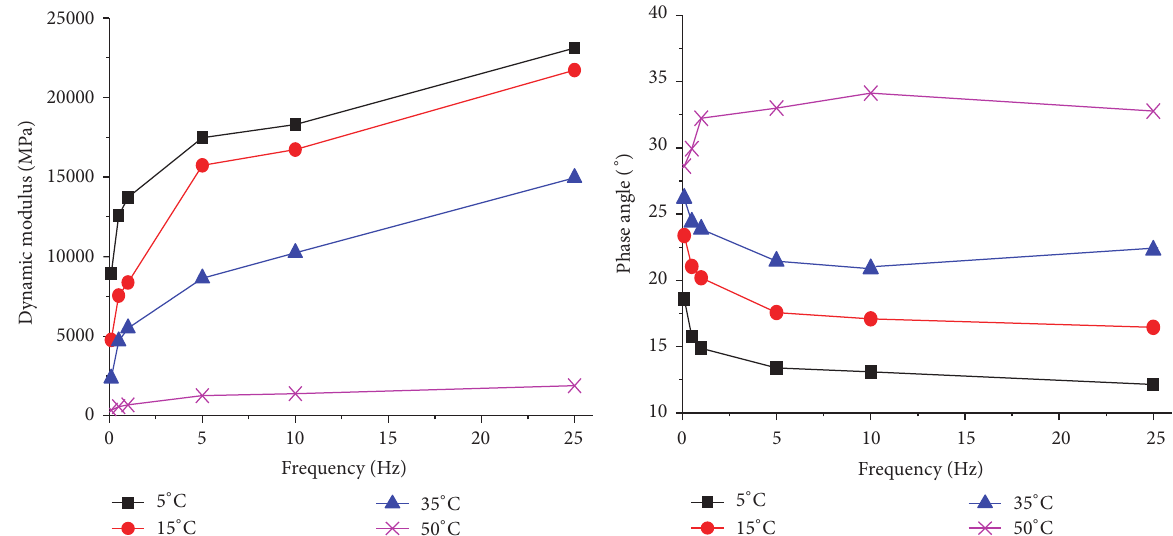
Figure 3: The dynamic modulus and phase angle of DCLR-composite modified asphalt